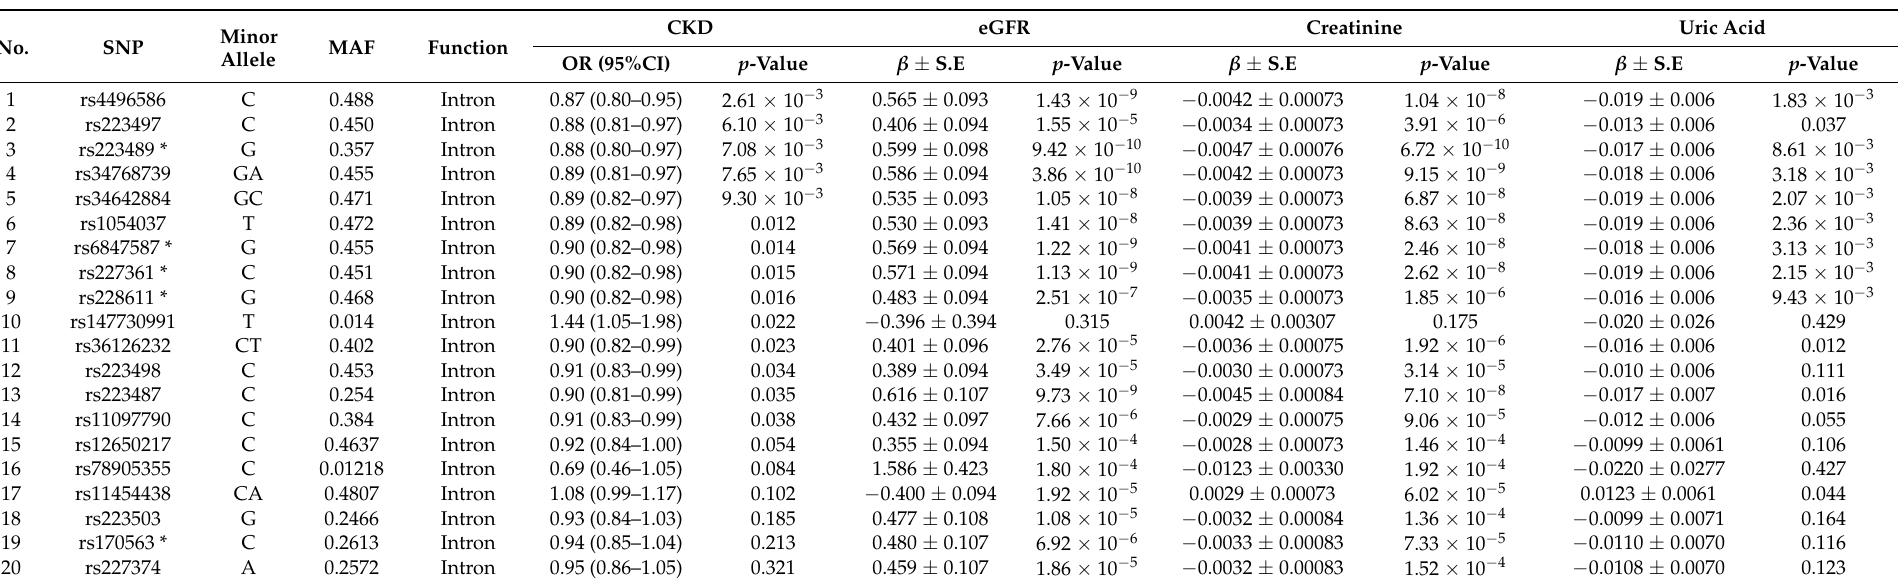
Table 2. Results of association analysis of the SNPs in the MANBA gene with chronic kidney disease and kidney function-related traits ( r 2 <